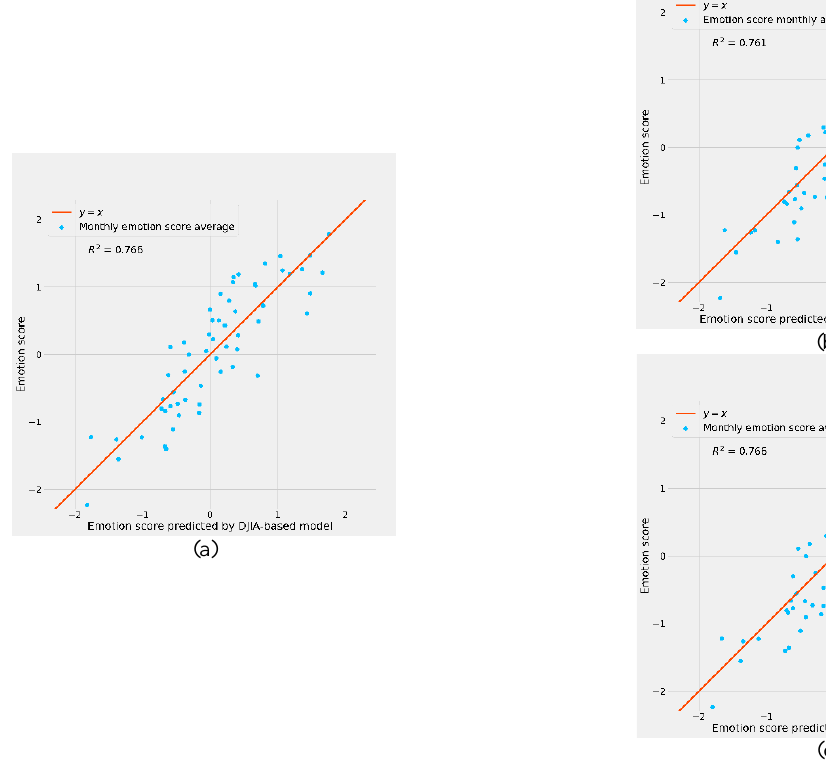
Figure 5 Multiple regression results for emotion